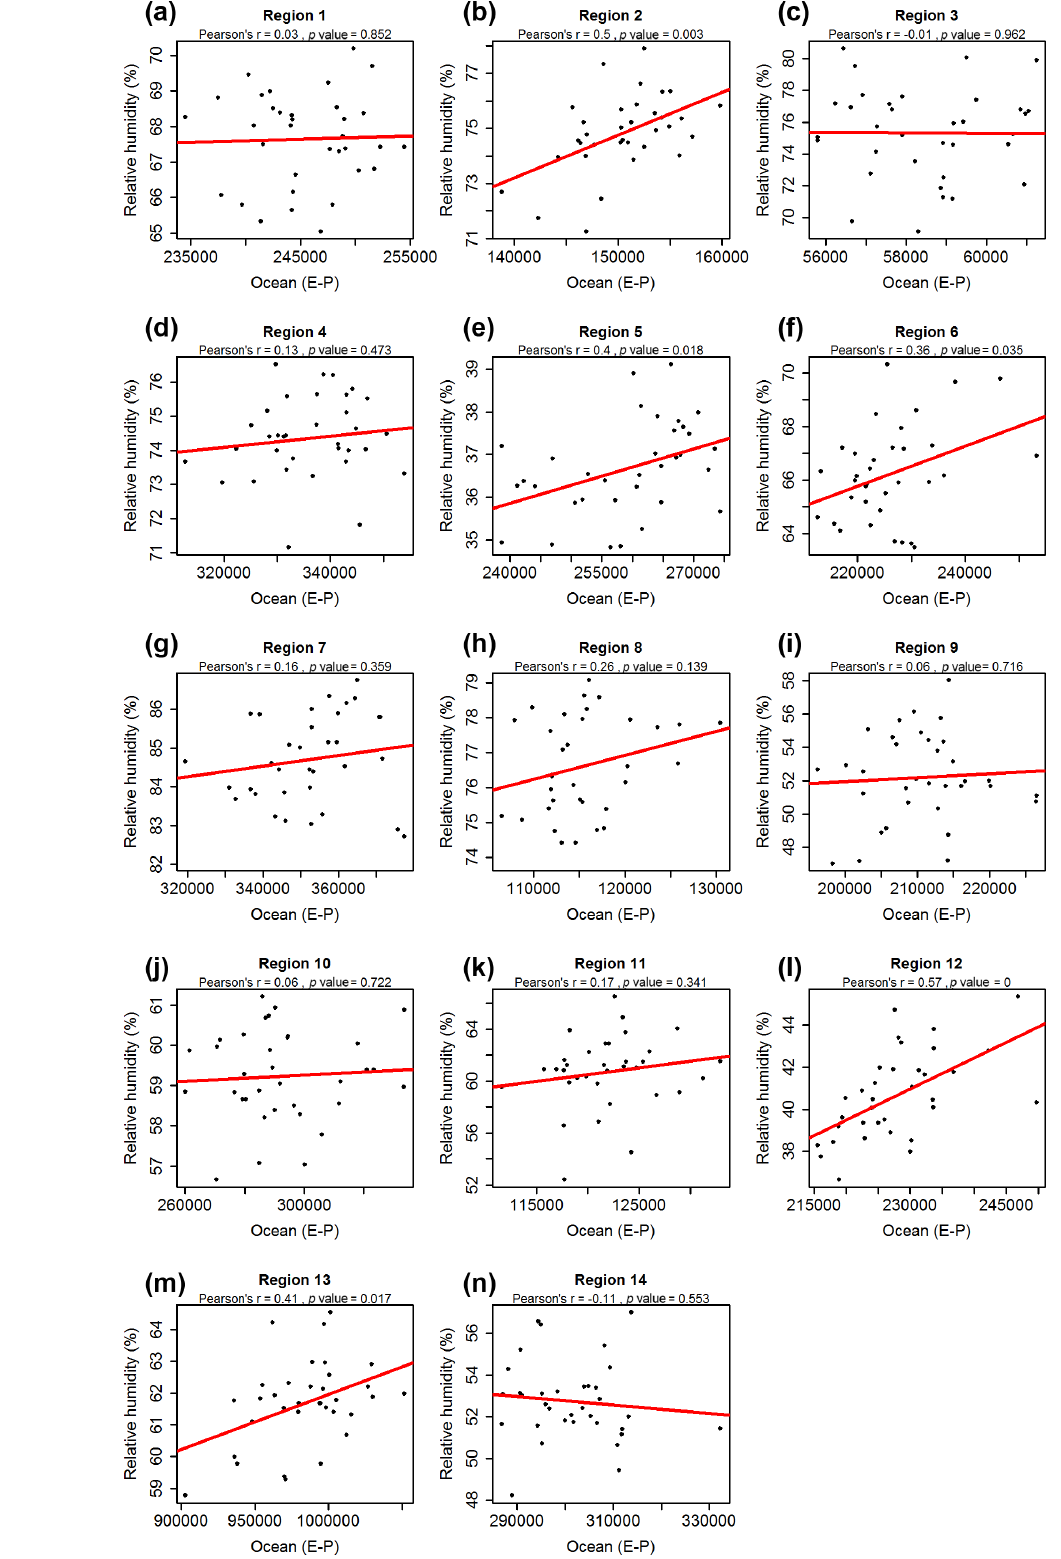
Figure 8. Relationships between the annual oceanic contribution to annual precipitation ( E – P ) and the annual RH in the target regions.